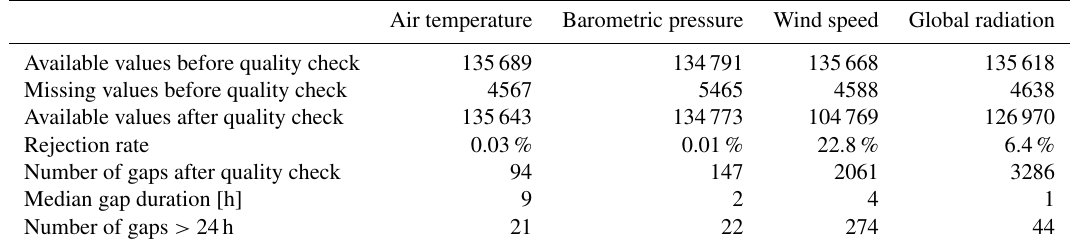
Table 3. Summary of the quality checks performed for the CM weather series. Wind direction (see Table 1) is not included as not relevant for EBFM modeling.